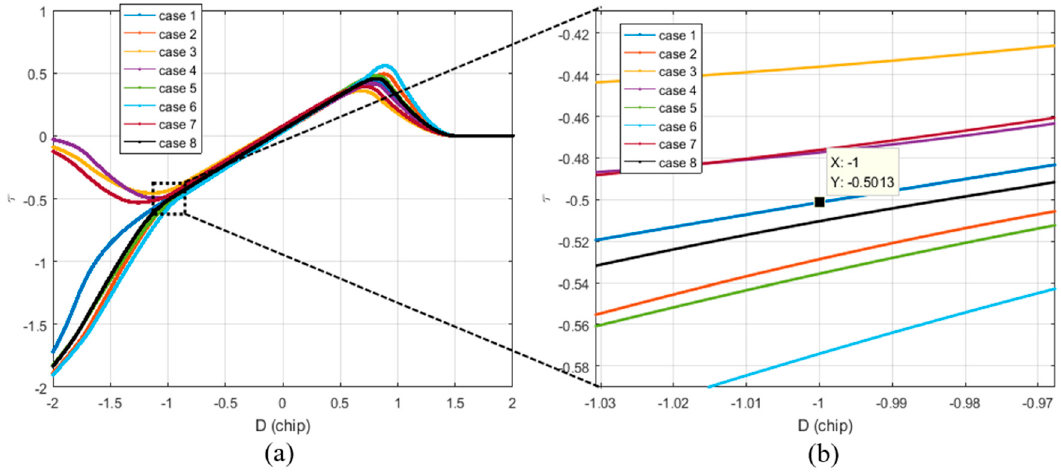
τ Figure 7. Different τ values at D is − 1 according to the various spoofing attack scenarios. ( a ) Overall τ Table 3. Integration time calculation according to CI. Figure 7. Different values at D is -1 according to the various spoofing attack scenarios. (a) Overall τ τ histories; ( b ) τ values at D is − histories; (b) values at D is -1.